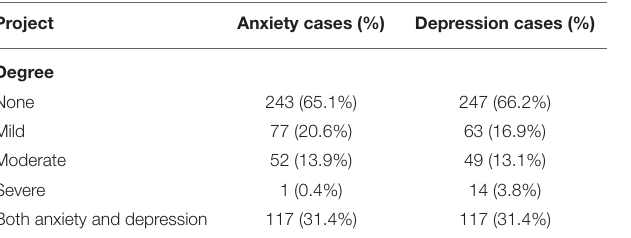
TABLE 1 | The results of anxiety and depression in 373 tumor radiotherapy patients during COVID-19 pandemic. Project